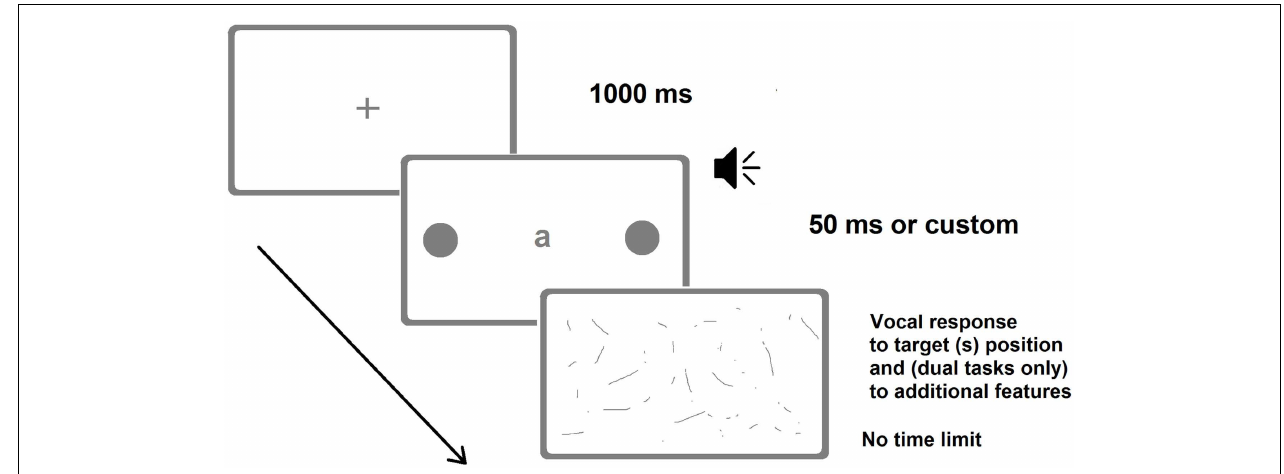
verbally reported either the position of the target(s) only (in the single-task condition) or the identity of the letter and the position of the target(s) (visual dual-task) or counted twice by two from the number they heard and then reported the position of the target(s) (auditory dual-task). Image not to